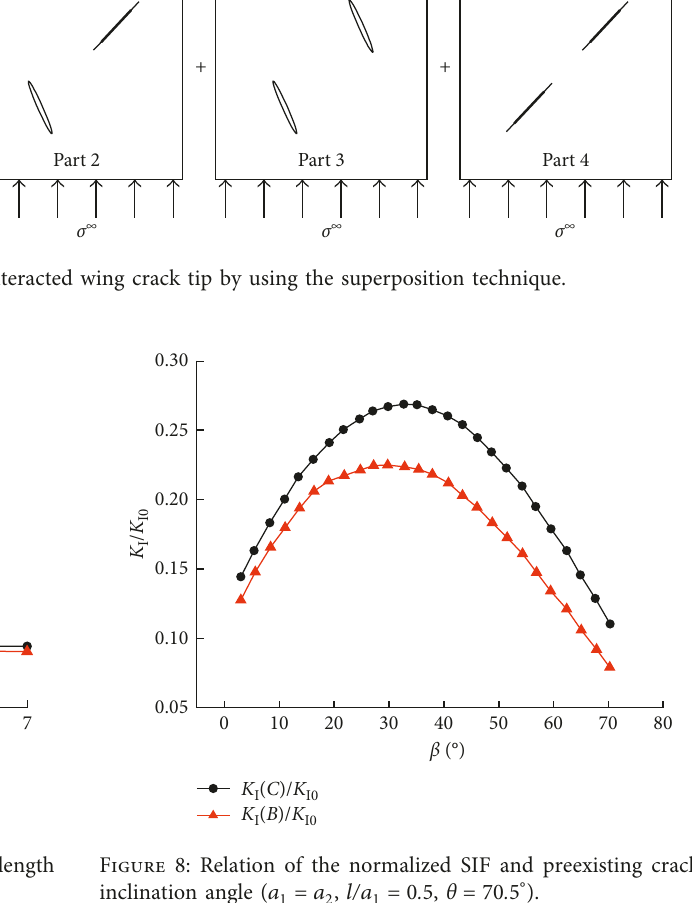
a l/a . 5, θ 70 . 5 ° 2 , 1 (cid:31) 0 (cid:31) (cid:31)